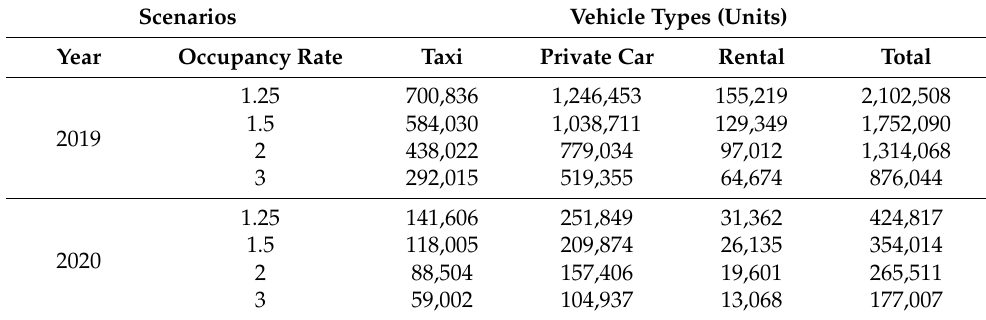
Table 3. Passenger car traffic scenarios according to occupancy rates, for years 2019 and 2020.